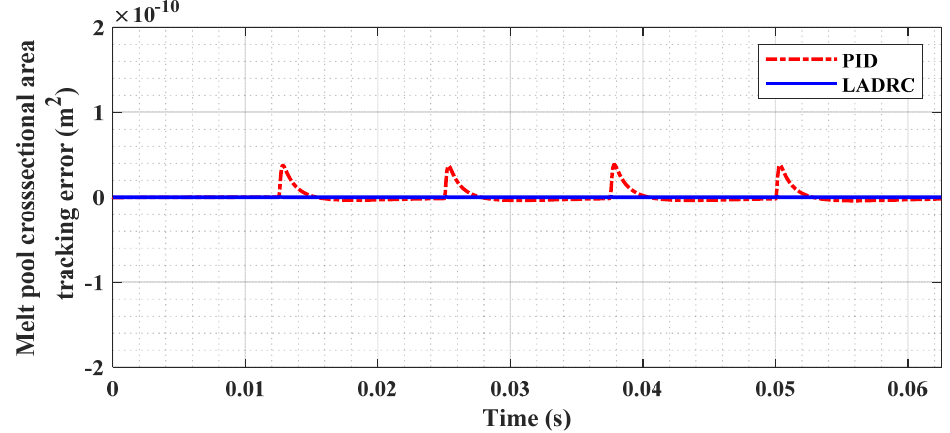
Figure 8. Melt pool cross ‐ sectional area tracking error.